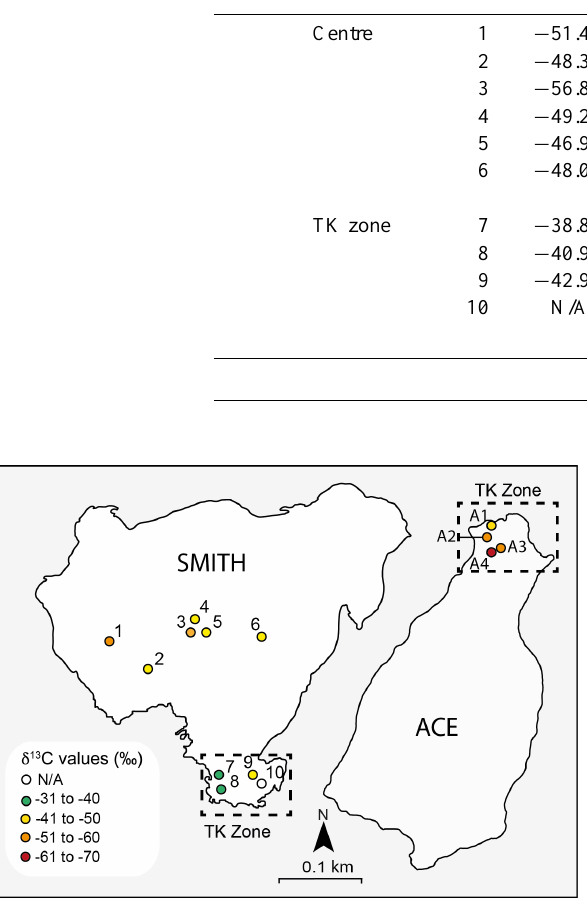
Figure 3. Diploptene δ 13 C values at Smith Lake and Ace Lake. In general the lowest are found in Ace and in the centre of Smith. The thermokarst zone at Smith Lake has the highest values for the whole data